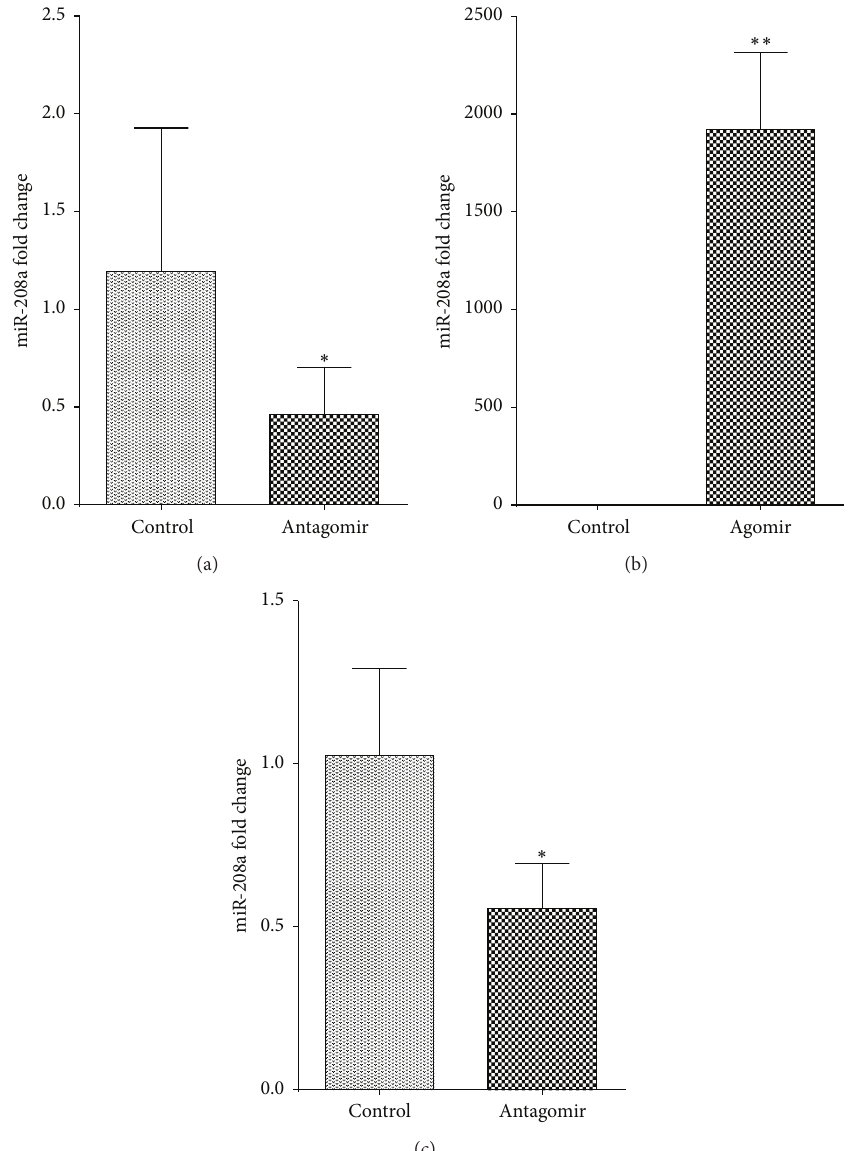
Figure 1: miR-208a agomir and antagomir transfection significantly upregulated or downregulated miR-208a, respectively ( ∗ 𝑝 < 0.05 , ∗∗ 𝑝 < 0.001 ). (a) miR-208a antagomir transfection significantly downregulated miR-208a in cultured neonatal cardiomyocytes 48 hours after transfection ( 𝑛 = 4 samples per group). (b) Agomir transfection into neonatal cardiomyocytes significantly upregulated miR-208a ( 𝑛 = 4 samples per group). (c) miR-208a antagomir significantly downregulated miR-208a at 28 days after MI ( 𝑛 = 4 per group).